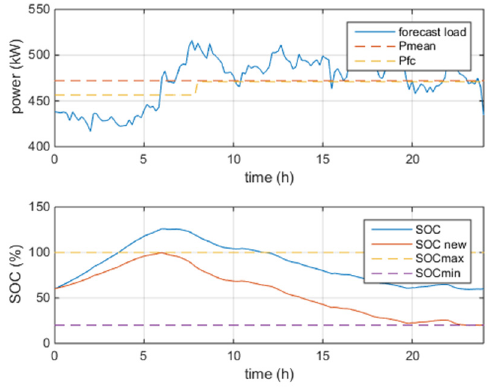
Figure 4. Sample power and SOC profiles with and without reshaping.